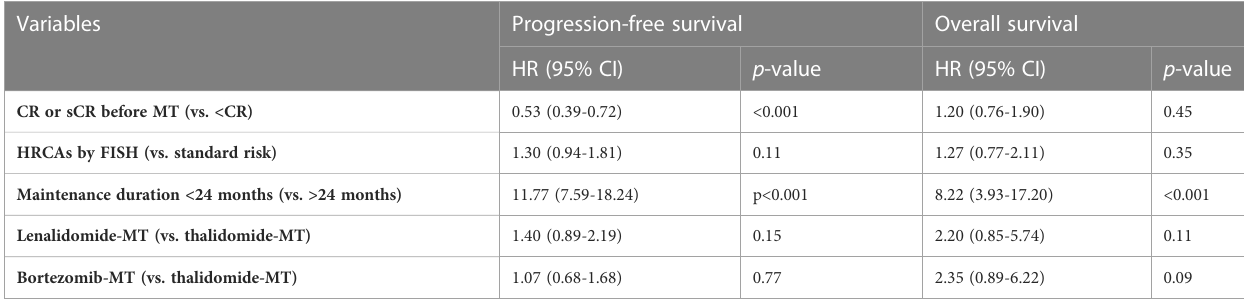
TABLE 3 Multivariate analysis by Cox model for lenalidomide or bortezomib vs. thalidomide maintenance. Variables Progression-free survival Overall survival HR (95% CI) p -value HR (95% CI) p- value CR or sCR before MT (vs.